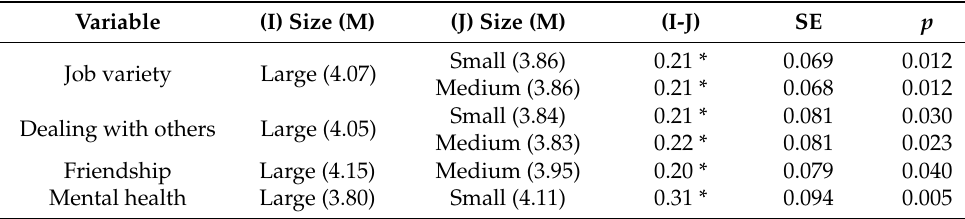
Table 5. Post hoc tests—significant differences between the organizations of different